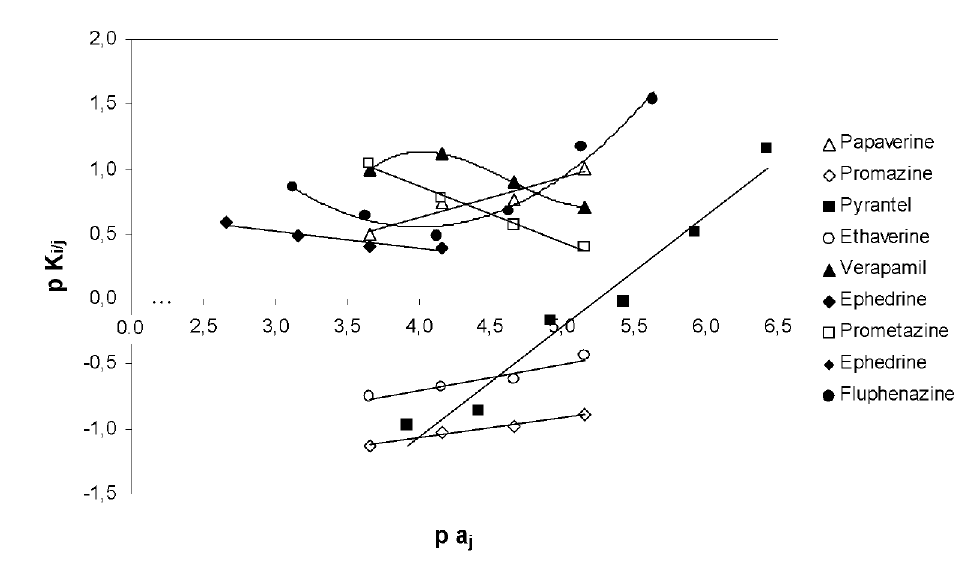
Fig. 5 The curves of changes of electrode selectivity coe¯ cient for several drug organic